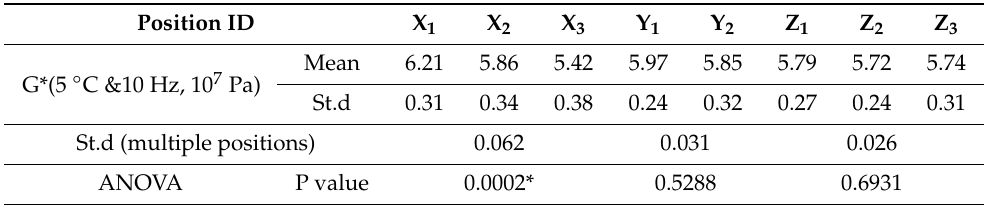
Table 3. Parameter G* of the mastics at di ff erent positions and sensitivity analysis of di ff erent positions to G*.